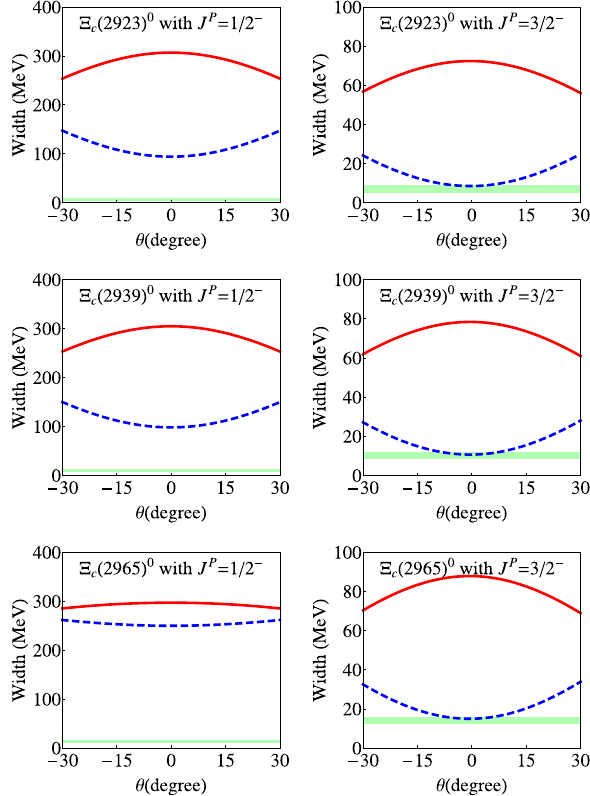
Fig. 2 The total decay widths under various assignments as functions of the mixing angle θ in the range of − 30 ◦ ∼ 30 ◦ . The red solid lines stand for the | 1 P 1 / 2 − (cid:8) 1 and | 1 P 3 / 2 − (cid:8) 1 states, and the blue dashed curves are the | 1 P 1 / 2 − (cid:8) 2 and | 1 P 3 / 2 − (cid:8) 2 states. The green bands stand for the experimental total decay widths gence with a nonzero mixing angle. The dependence on the mixing angle θ in the range of − 30 ◦ ∼ 30 ◦ are presented in Fig. 2. It is shown that the two J P = 1 / 2 − states can be excluded, while the J P = 3 / 2 − assignments are